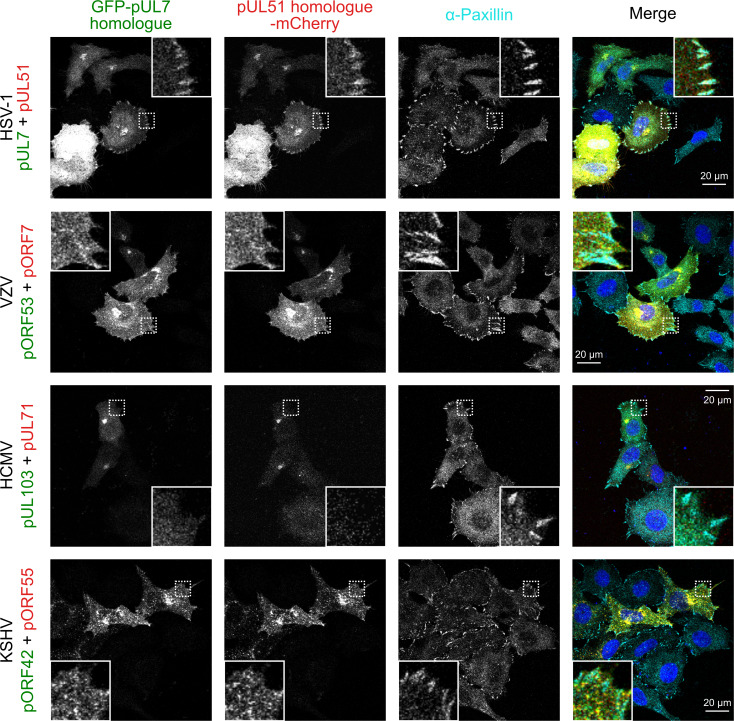
The pUL7:pUL51 complex from HSV-1 co-localizes with focal adhesion marker paxillin, but homologues from other human herpesviruses do not.HeLa cells were co-transfected with GFP-pUL7 and pUL51-mCherry, or with similarly-tagged homologues from VZV, HCMV and KSHV. Cells were fixed 24 hr post-transfection and immunostained for the focal adhesion marker protein paxillin before imaging by confocal microscopy. Co-localization between the GFP, mCherry and far-red (paxillin) fluorescence was only observed for cells transfected with HSV-1 pUL7-GFP and pUL51-mCherry. Images are representative of experiments performed in two cell lines (U2-OS osteosarcoma cells and HeLa cells).